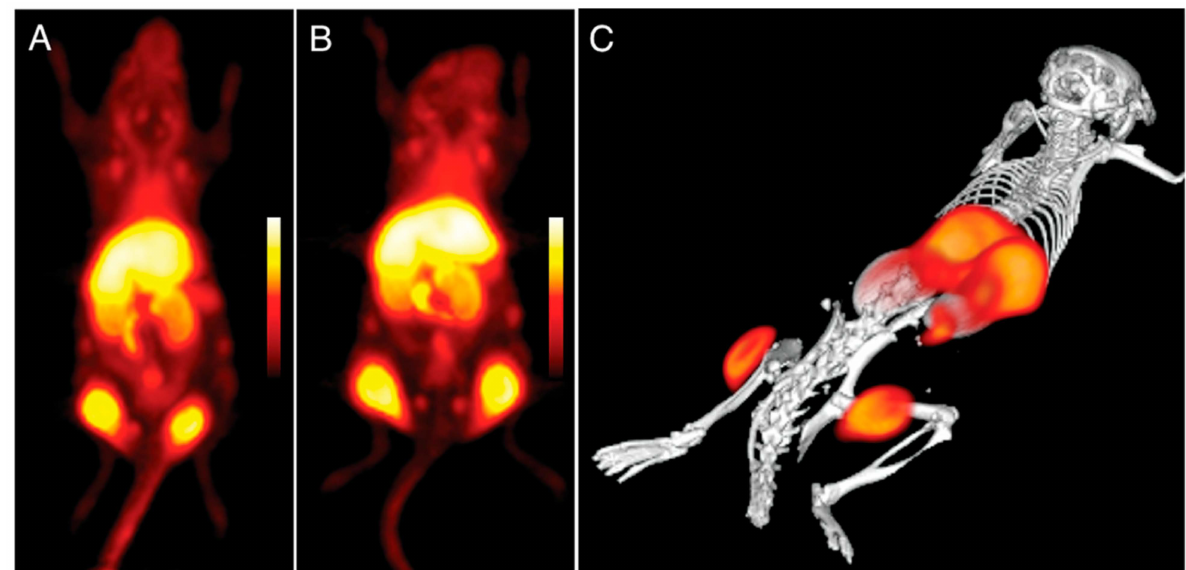
Figure 13. Imaging using 89Zr-labeled DNPs using PET in mice with bilateral flank tumors (24 h after administration). ( A , B ) Two distinct animals with almost identical tumor distributions (coronal stacks). Panel A depicts an animal; panel ( C ) depicts a three-dimensional model of the animal [167].